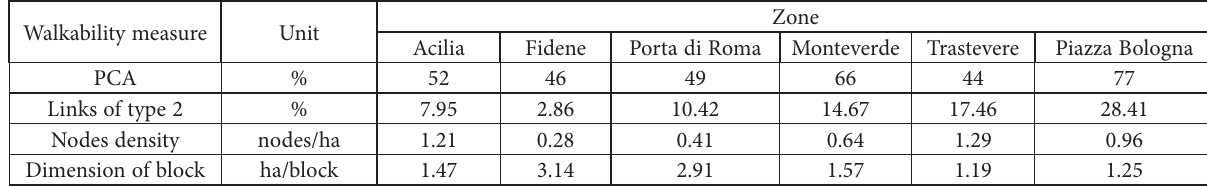
Table 5. Walkability measures for several zones in Rome (Gori et al., 2014) Walkability